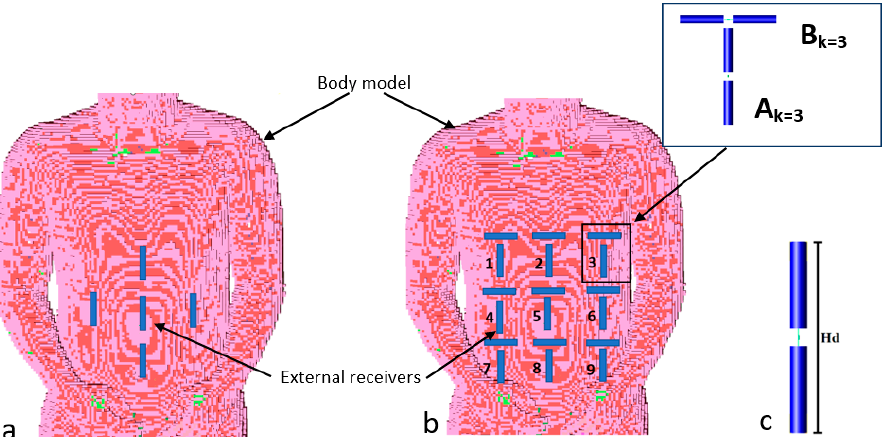
Figure 7. Arrangement of the external receivers on the human body, ( a ) base configuration presented in [9], ( b ) configuration used for adaptive receiver selection (A k : vertical receivers; B k : horizontal receivers), ( c ) receiving dipole Hd = 22